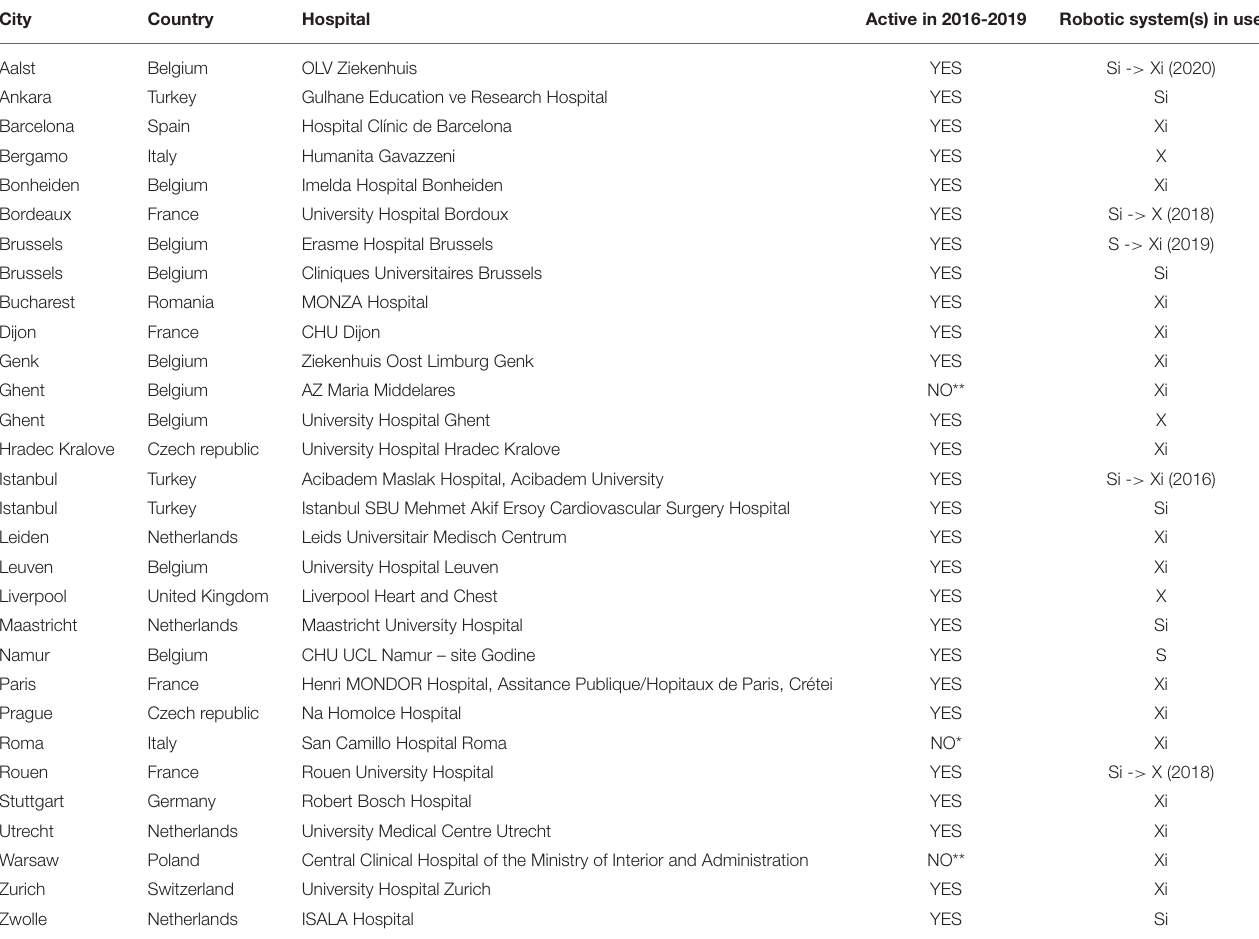
TABLE 1 | Centers currently performing robotic cardiac surgery and those active in years